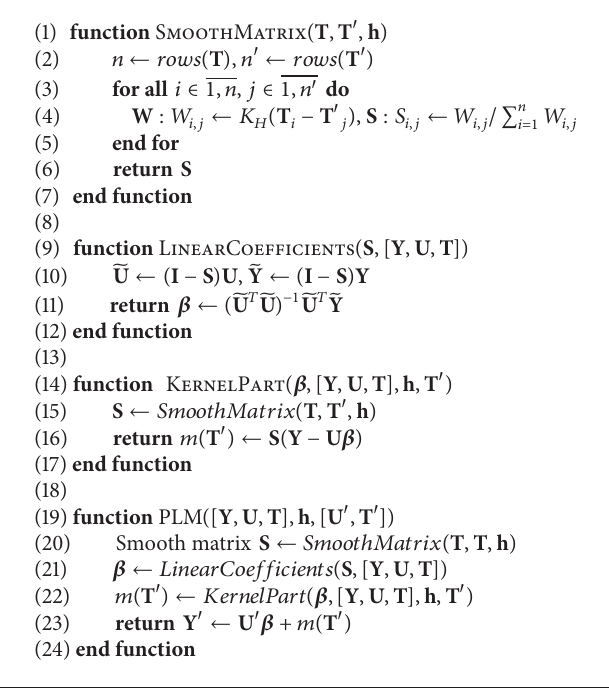
Algorithm 2: PLM estimation, training set: [ Y , U , T ] , test set: [ Y 󸀠 , U 󸀠 , T 󸀠 ]